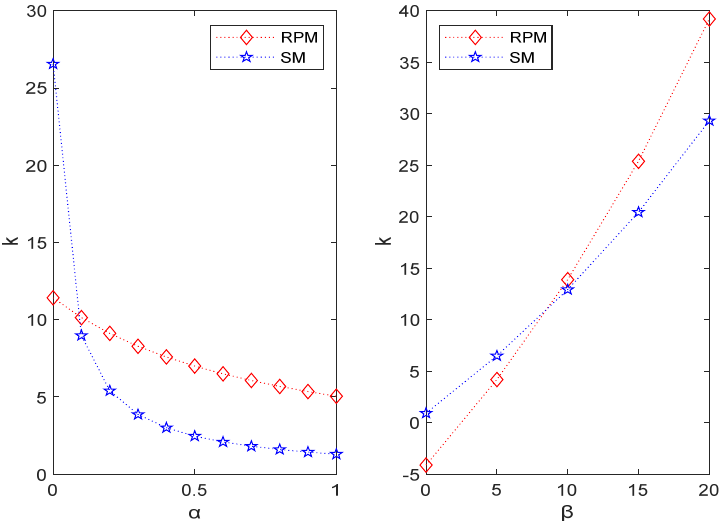
Figure 2. Intensity under RPM and SM vs. fixed cost coefficient ( left ) and environmental benefit coefficient ( right ).